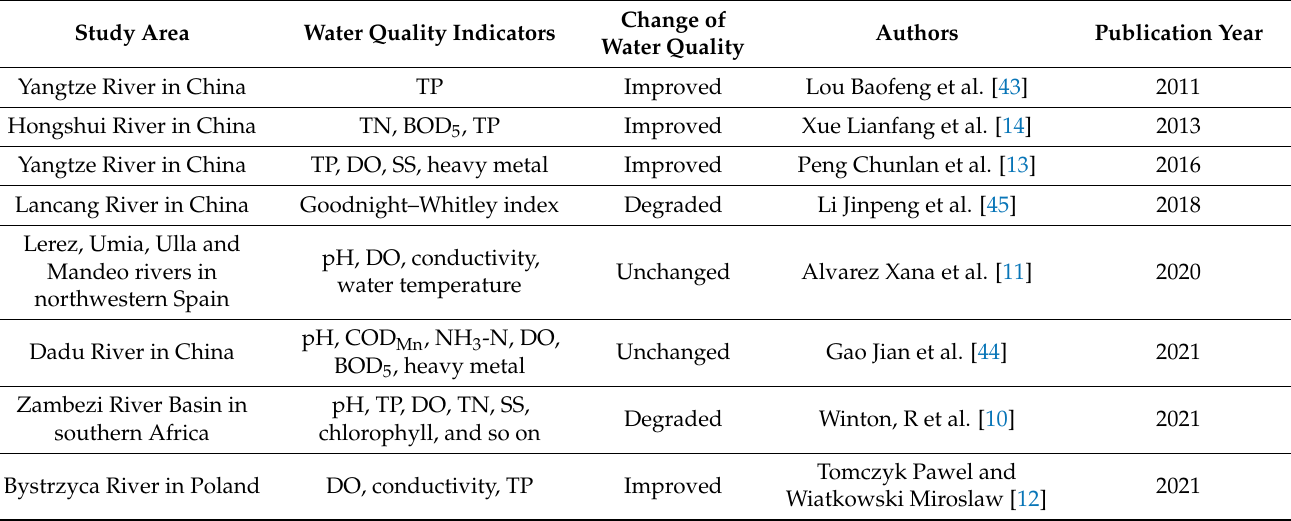
Table 7. Overview of water quality affected by hydropower development in other